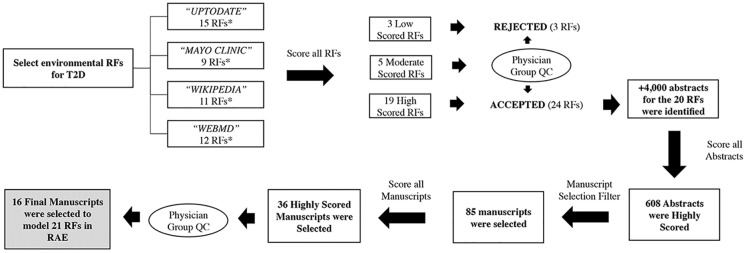
A flow diagram on how environmental RFs for T2D were identified and representative studies were selected to be modeled in the RAE.* Some RFs overlap between data sources.